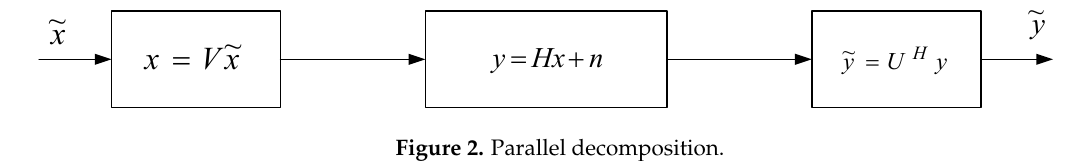
Figure 2. Parallel